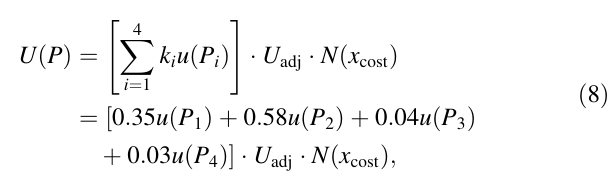
Table 5 Normalized uncertainty ranges of performance attributes Attributes